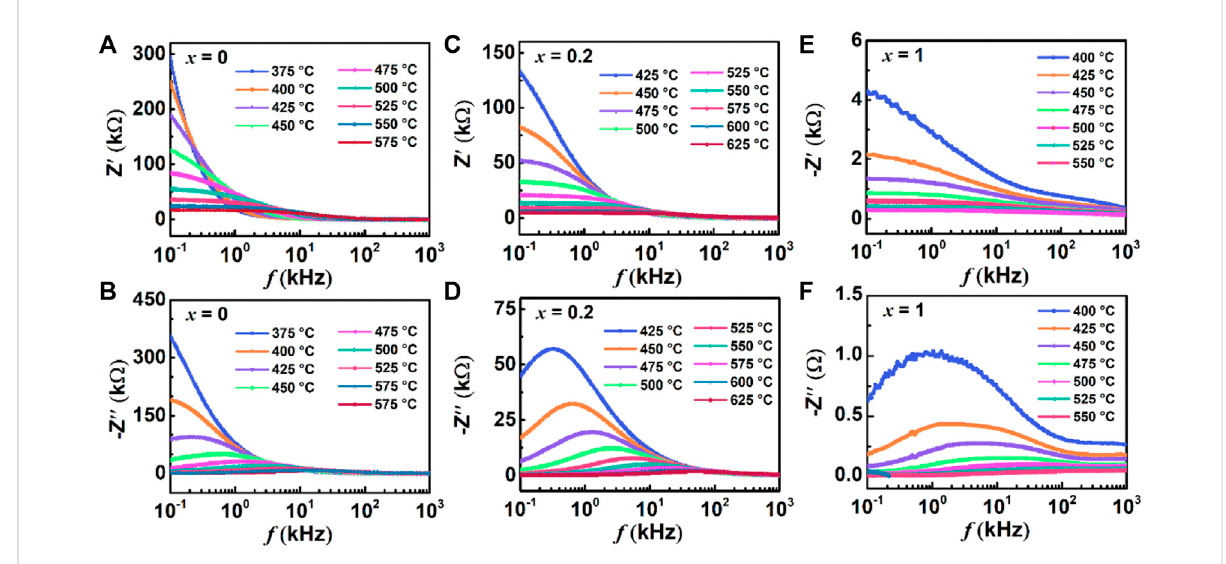
FIGURE 10 (Color online) Frequency variation of Z ʹ and Z ʺ from 100 Hz (cid:7) 1 MHz at various temperatures for(1- x ) BBT - x BiT ceramics: (A,B) BBT (C,D) 0.8BBT-0.2BiT, and (E,F)